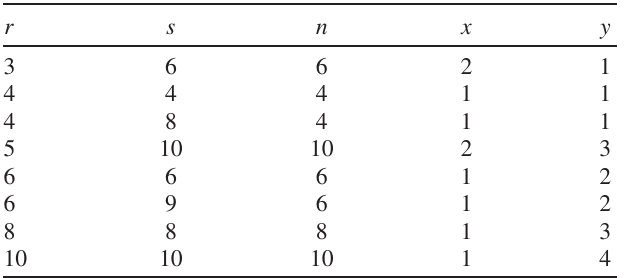
TABLE IV. Solutions to Eq. (H2) for all r; s ≤ 10 ; r ≤ s . By symmetry, solutions for r ≥ s can be found by exchanging column r with s and column x with y . For each tessellation f r; s g , we give the parameters n , x , y defining only one → Z homomorphism f ∶ G H þ (the homomorphism which min- n r;s imizes both n and x ). There are at least two solutions for each tessellation.